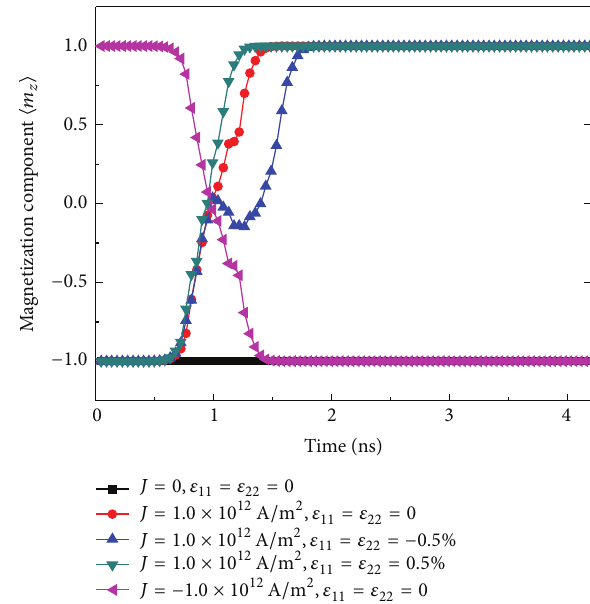
Figure 3: Time evolution of magnetization components ⟨𝑚 𝑧 ⟩ with different current densities and substrate misfit